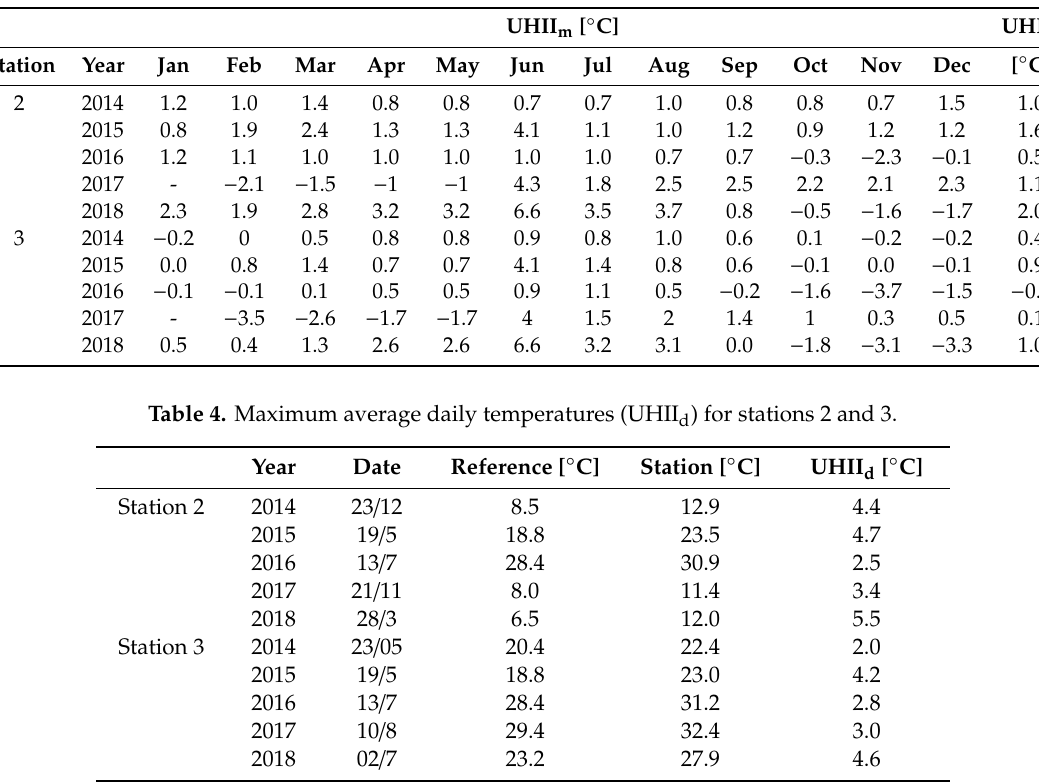
Table 3. Values of Urban Heat Island Intensity (UHII) monthly average temperatures (UHII m ) and annual average temperature (UHII y ) at stations 2 and 3.